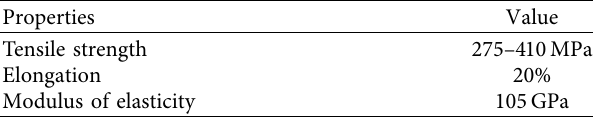
Table 1: Mechanical properties of pure titanium grade 2.